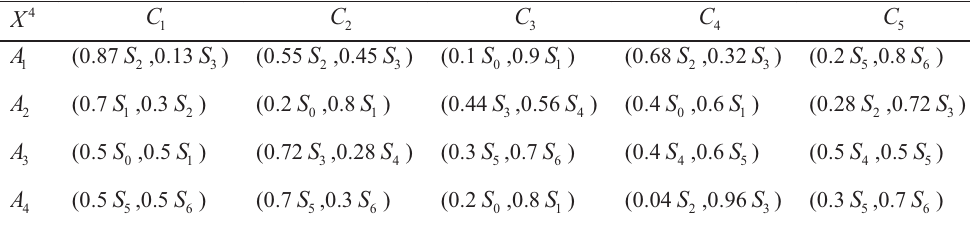
Table 4. The linguistic evaluation matrix 4 X provided by the decision maker